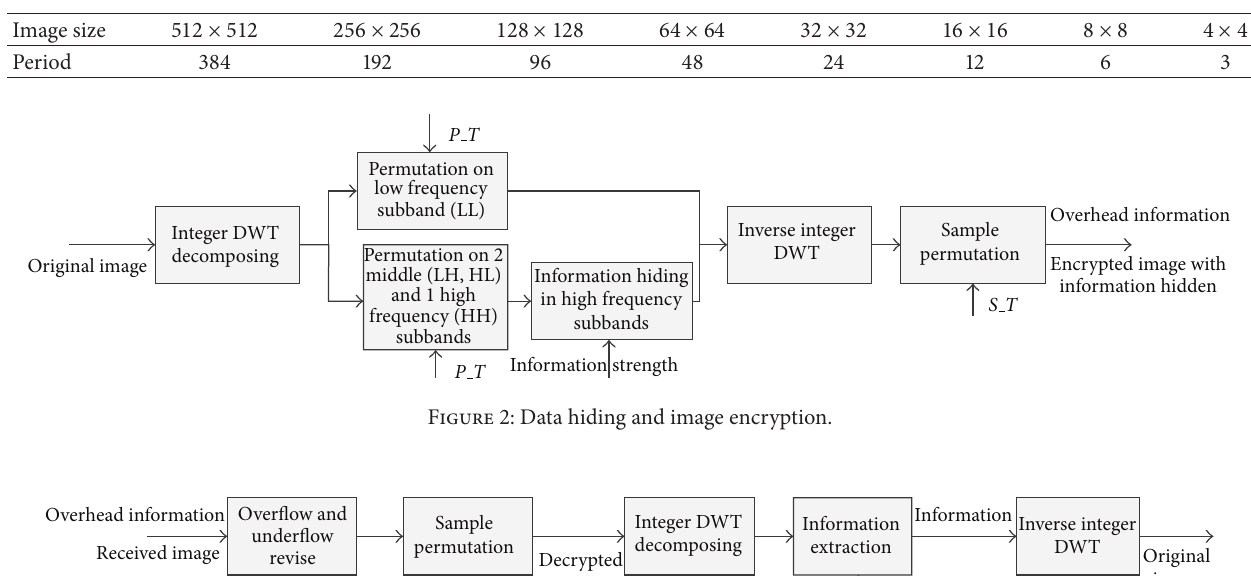
Table 1: Arnold permutation periods of images with different sizes.